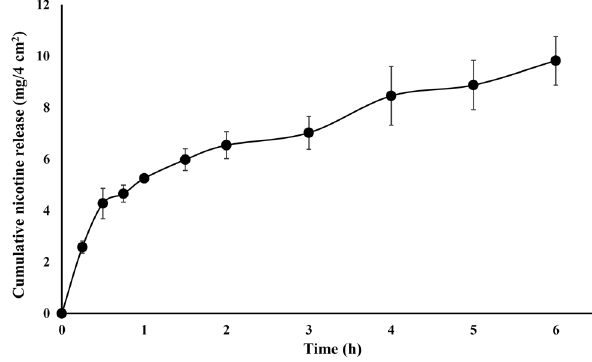
Figure 3: In vitro release of nicotine from buccal fi lm.